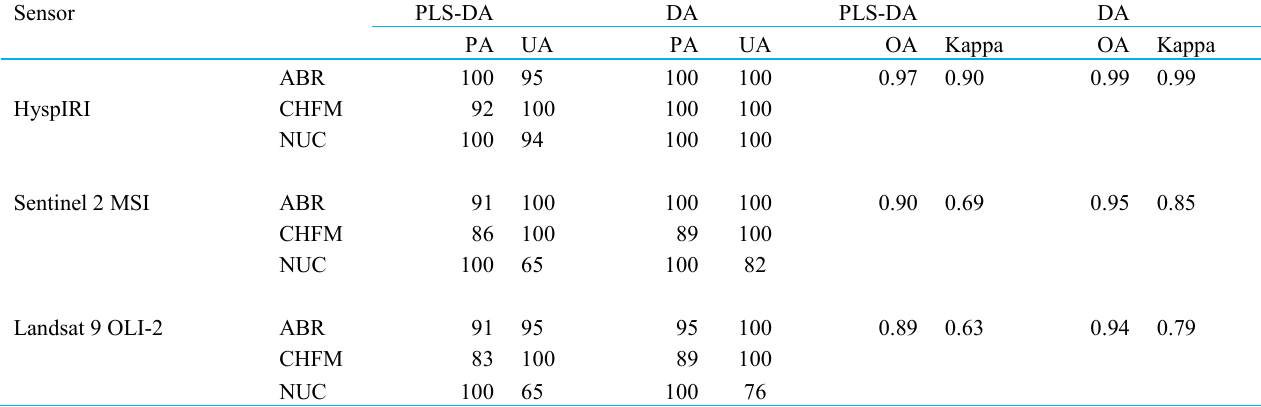
Table 2: Classification accuracies derived using HyspIRI, Sentinel 2 MSI and Lands 9 OLI-2 spectral settings